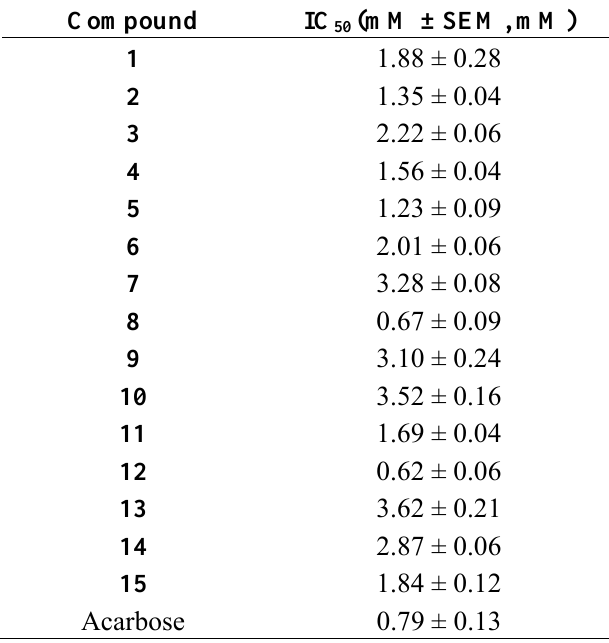
Table 2 . In vito α -glucosidase inhibitory